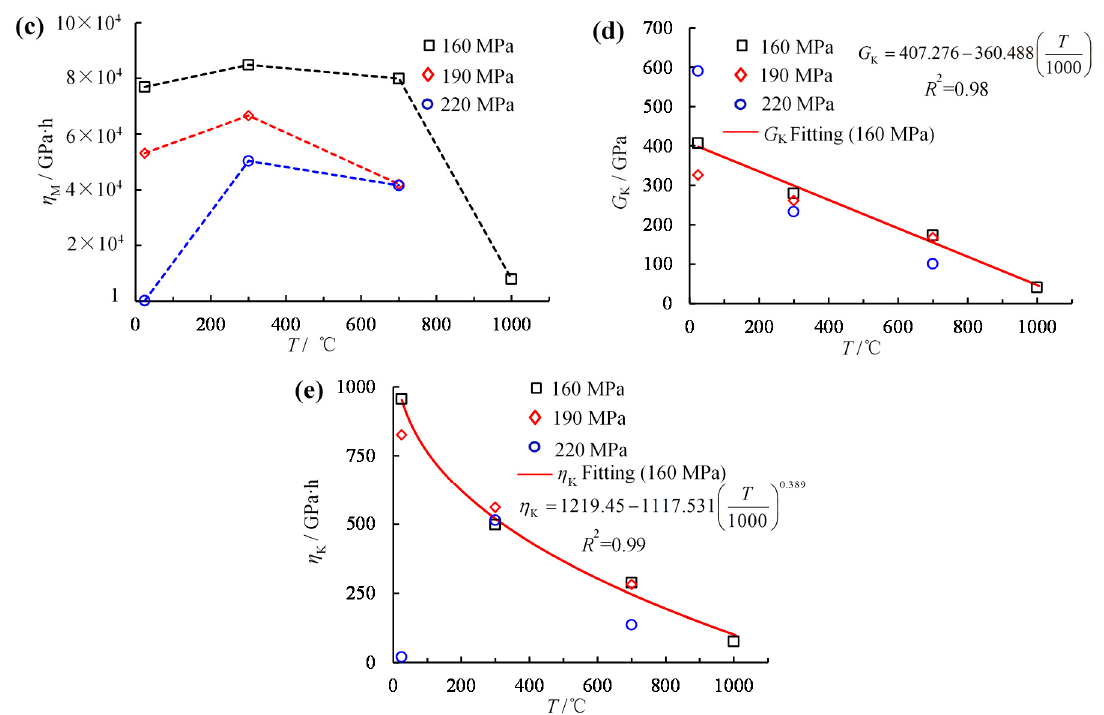
Figure 15. Relation between creep parameters and temperature: ( a ) K ; ( b ) G M ; ( c ) η M ; ( d ) G K ; ( e ) η K .